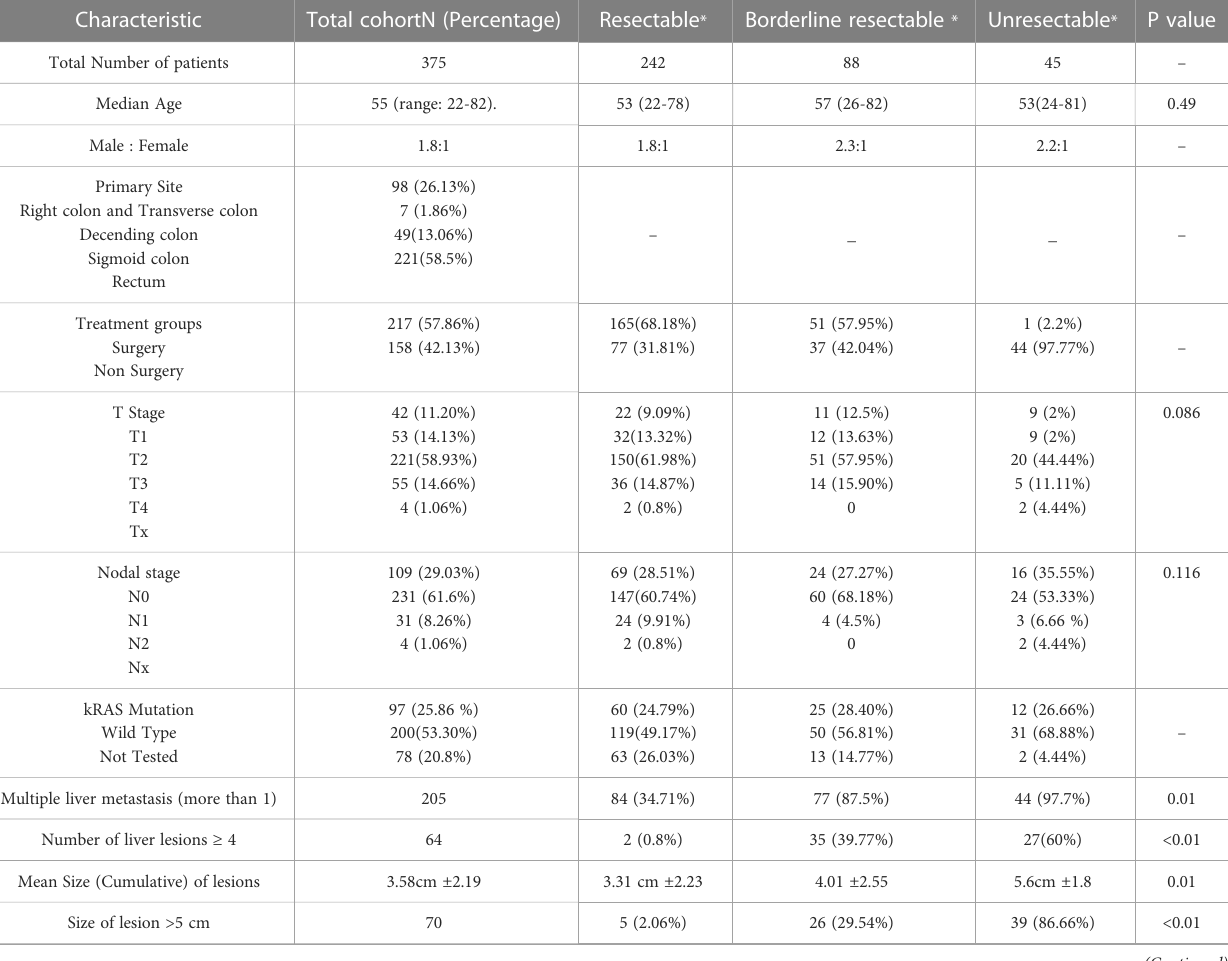
TABLE 2 List of primers used in this